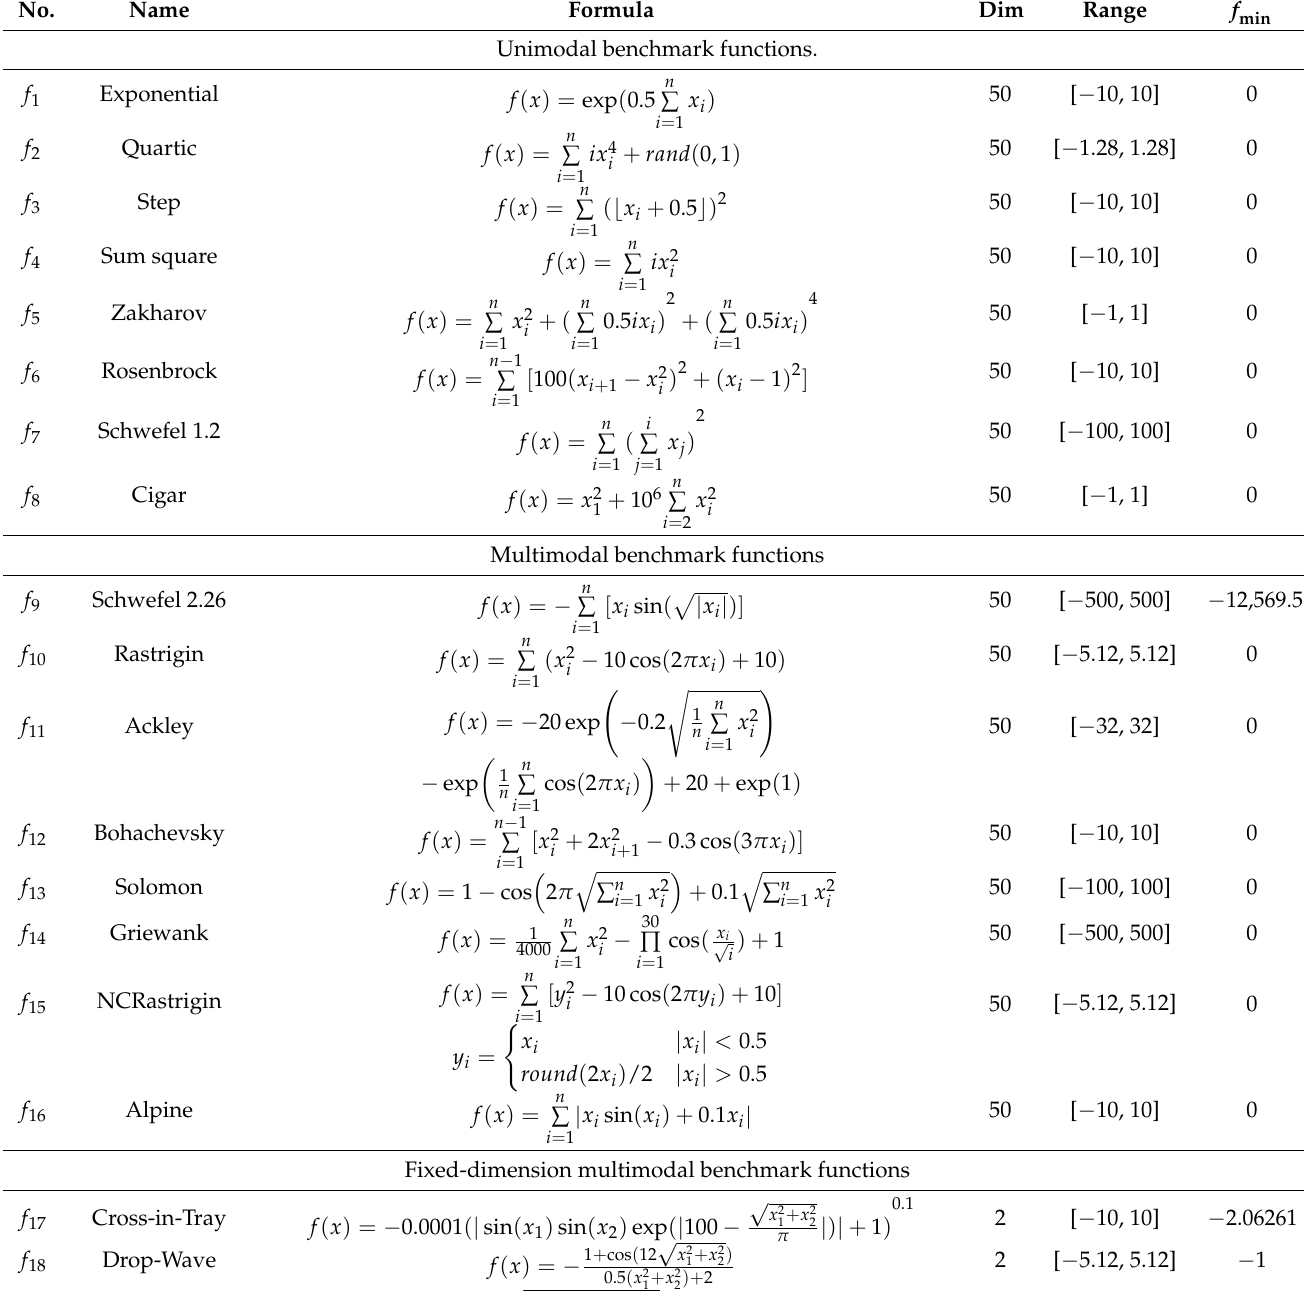
Table 1. The benchmark functions used in this